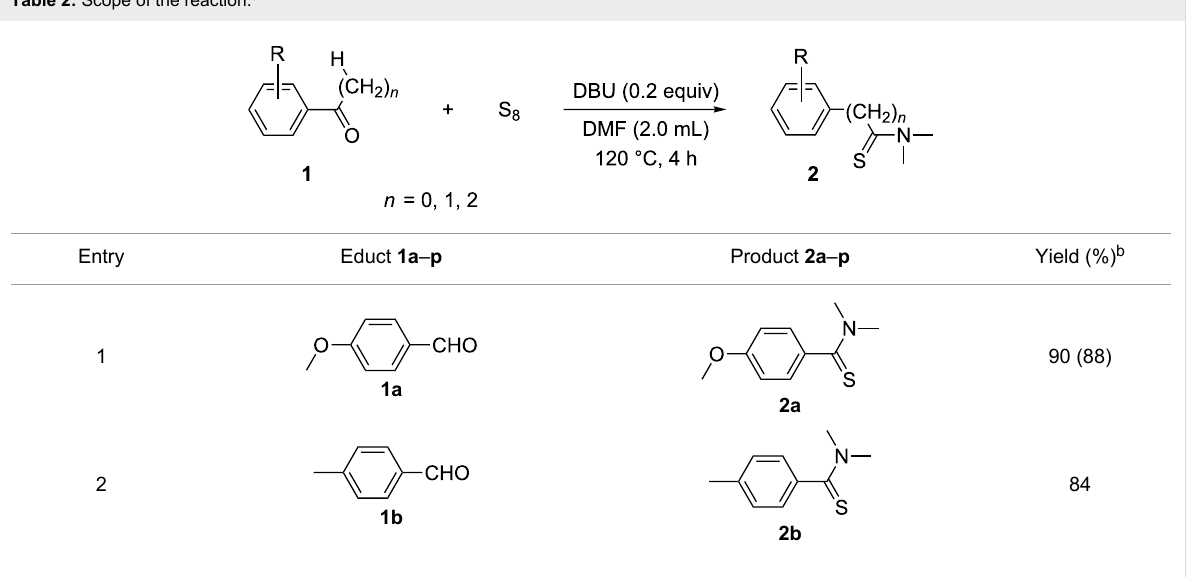
Table 2: Scope of the reaction. a